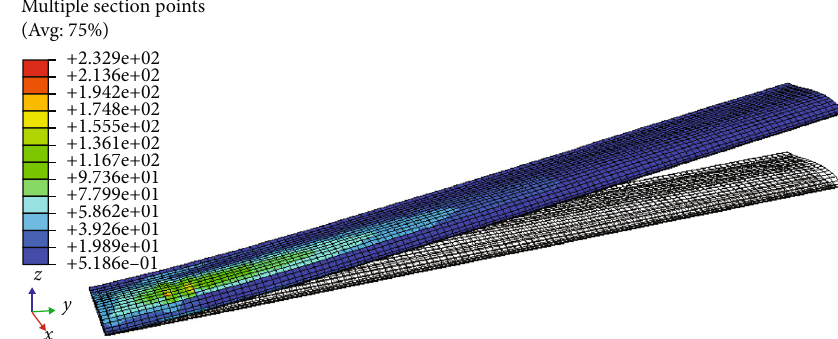
Figure 19: Cloud chart of deformation displacement